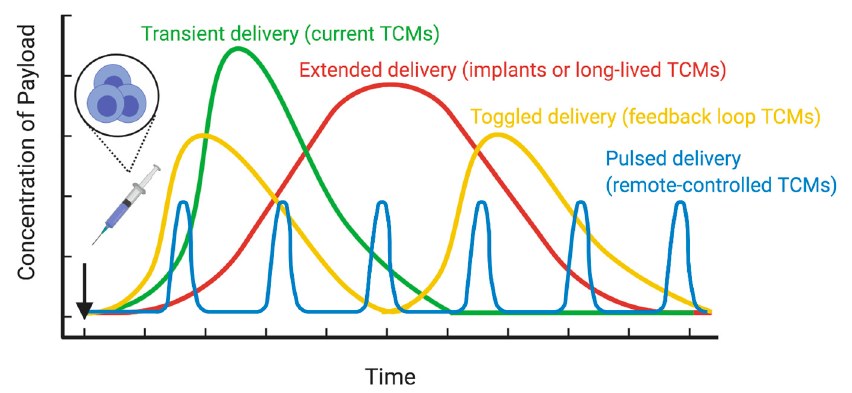
Figure 4. Hypothetical TCM drug delivery profiles.